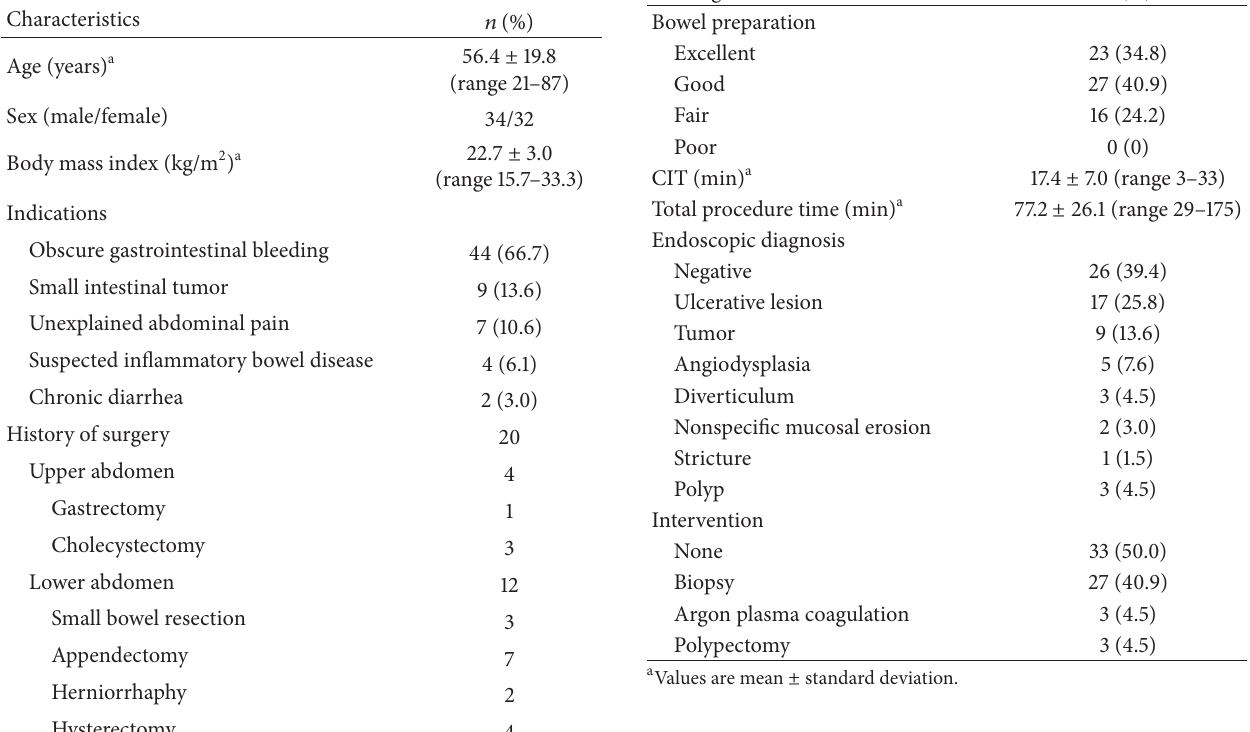
Table 3: Univariate analysis of predisposing factors for